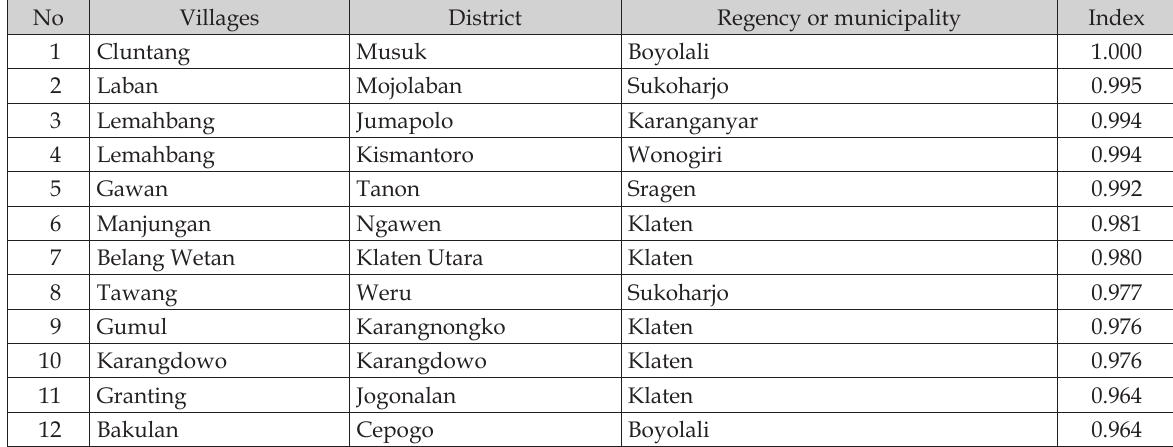
Table 8. List of villages with the high vulnerability index in Greater